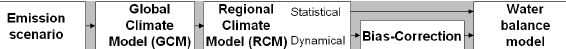
Fig. 3. Schematic diagram representing the elements of the climate impact modelling